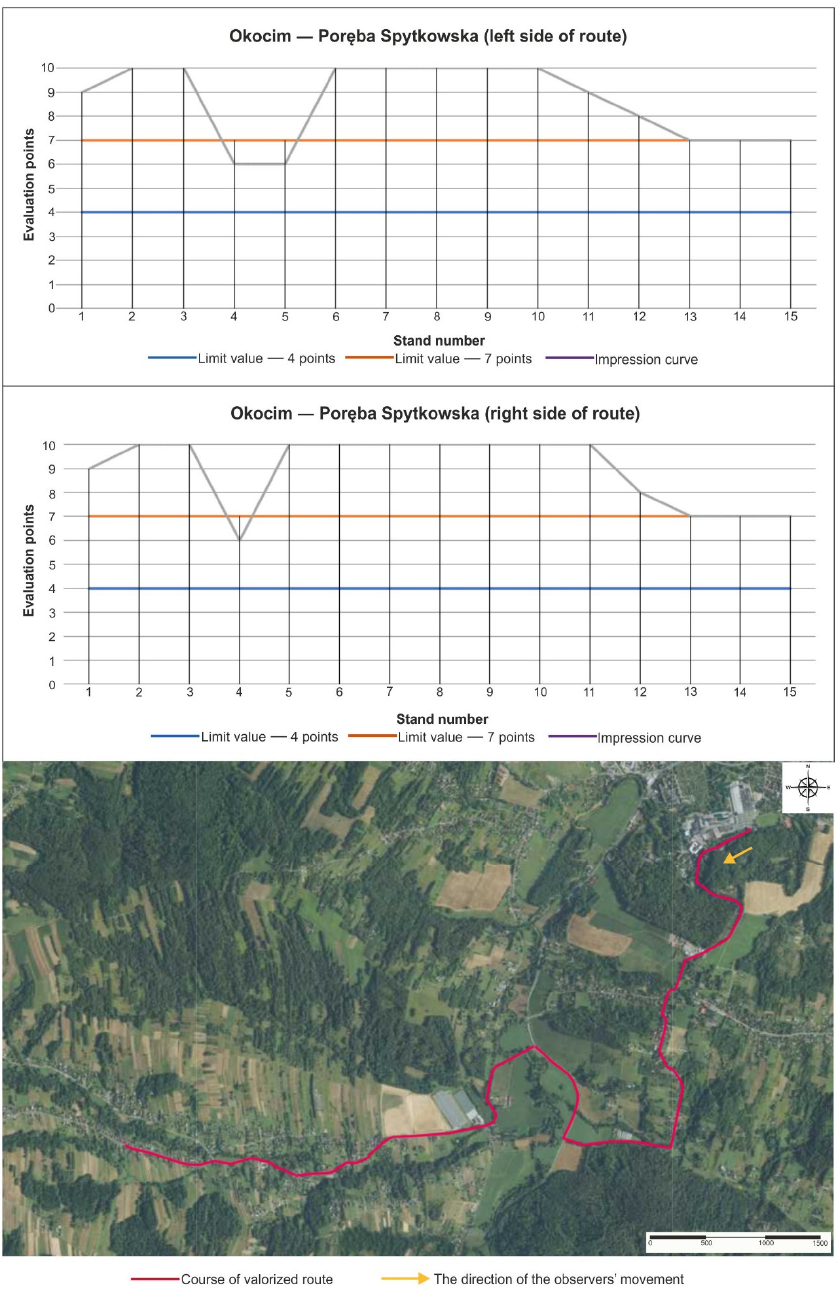
Figure 12. Impression curves for the Okocim—Por˛eba Spytkowska route (Commune of Brzesko). Commune of Iwkowa.